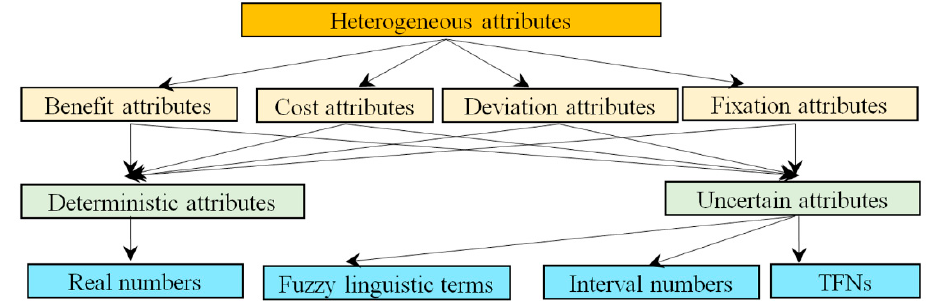
Figure 1. Heterogeneous attributes defined in the structural optimization of high-speed press. TFNs: triangular fuzzy numbers.